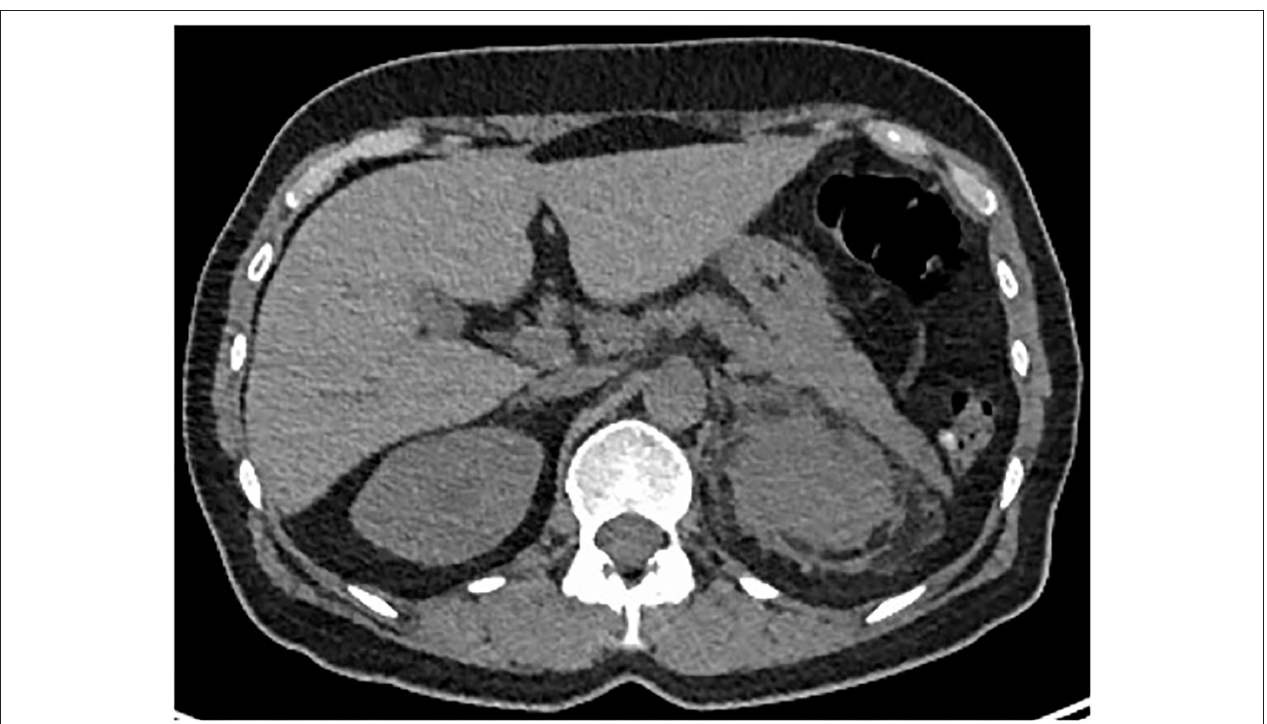
FIGURE 3 | Axial CT-Scan showing dense infiltration of left perinephric adipose tissue (“hairy